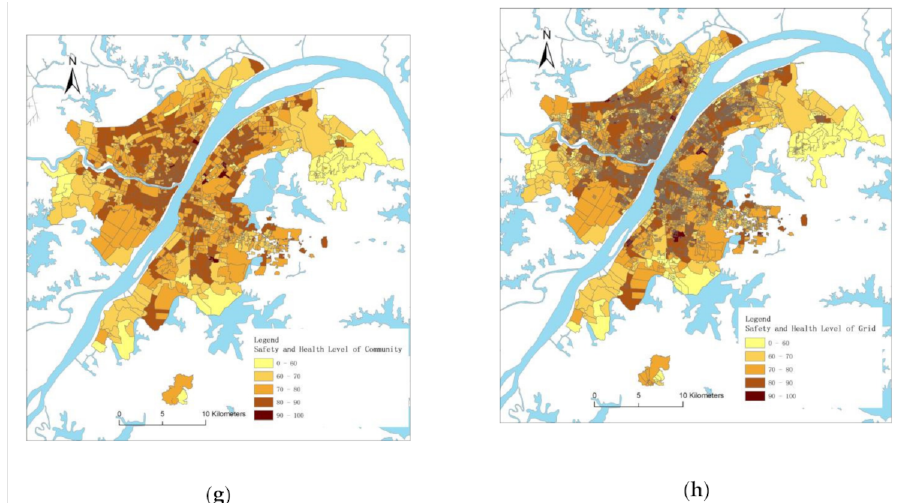
Figure 6. Spatial distribution of community livability indexes:( a ) Management score of community; ( b ) Management score of grid; ( c ) Residence environment score of community; ( d ) Residence environ- ment score of grid; ( e ) facility service score of community; ( f ) facility service score of grid; ( g ) Safety and health level of community; ( h ) Safety and health level of grid. ( b , d , f , h ) are graphed by the index scores of four dimensions calculated with grid data. ( a , c , e , g ) are graphed by weighted summarization of grid data in ( b , d , f , h